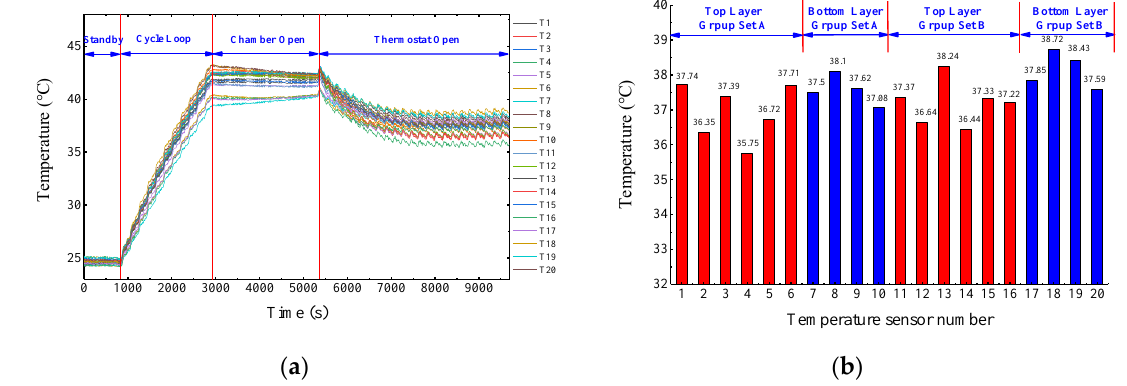
Figure 15. Temperature test result on a vehicle: ( a ) temperature curve during the complete test process; ( b ) temperature histogram of 20 thermocouples after temperature equilibration.